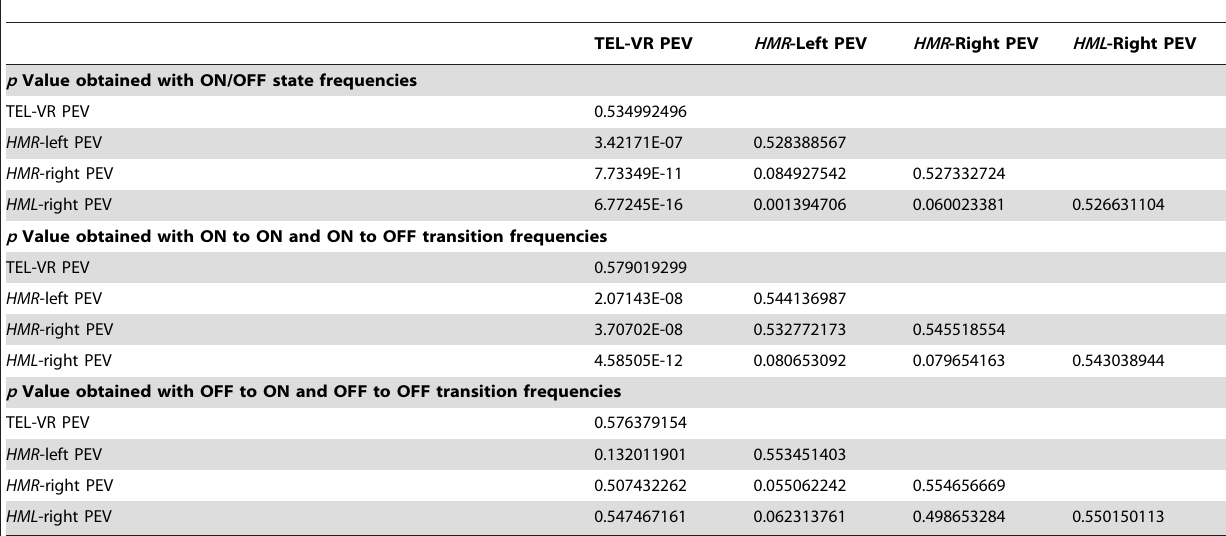
Table 2. p Values obtained with state and transition